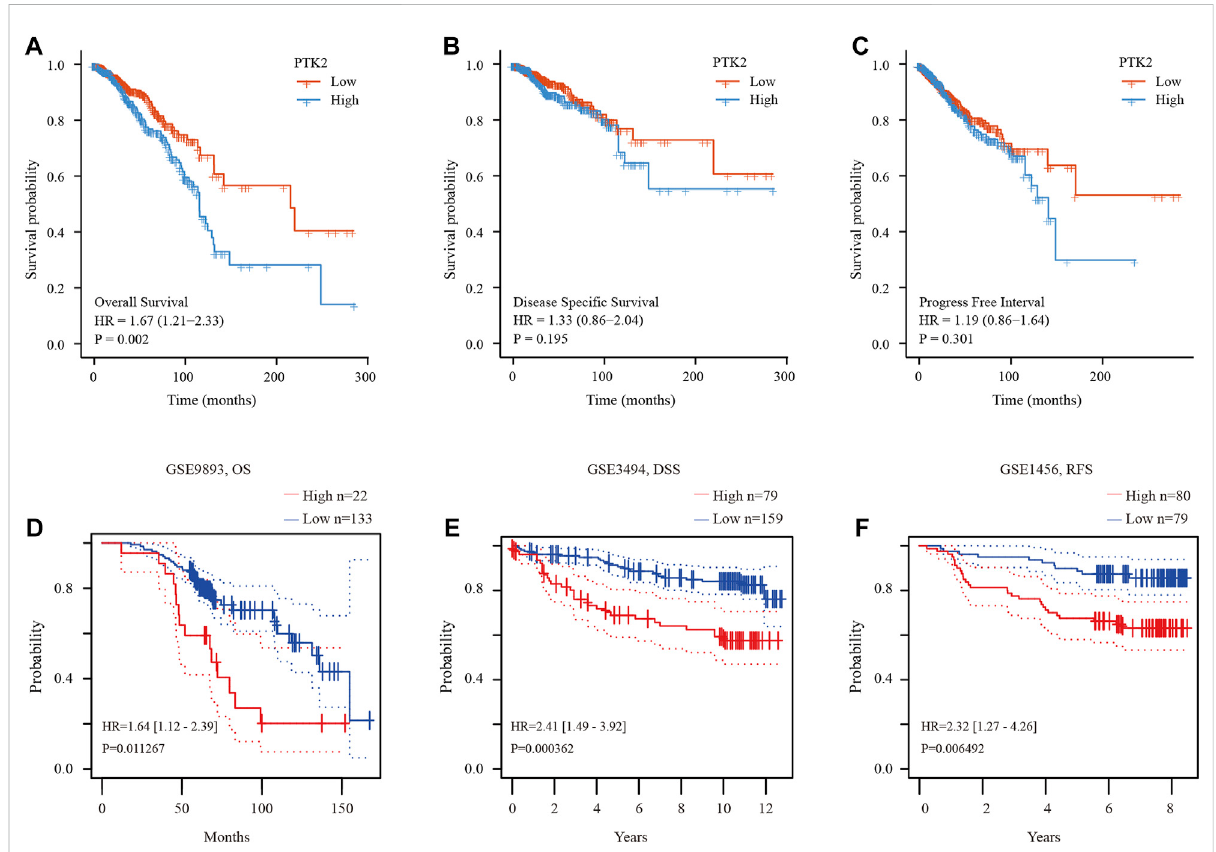
FIGURE 3 Prognostic value of PTK2 in breast cancer. (A – C) Survival curves of OS, DSS, and PFI from the TCGA database. (D – F) Survival curves using the PrognoScan database are shown for OS, DSS, and